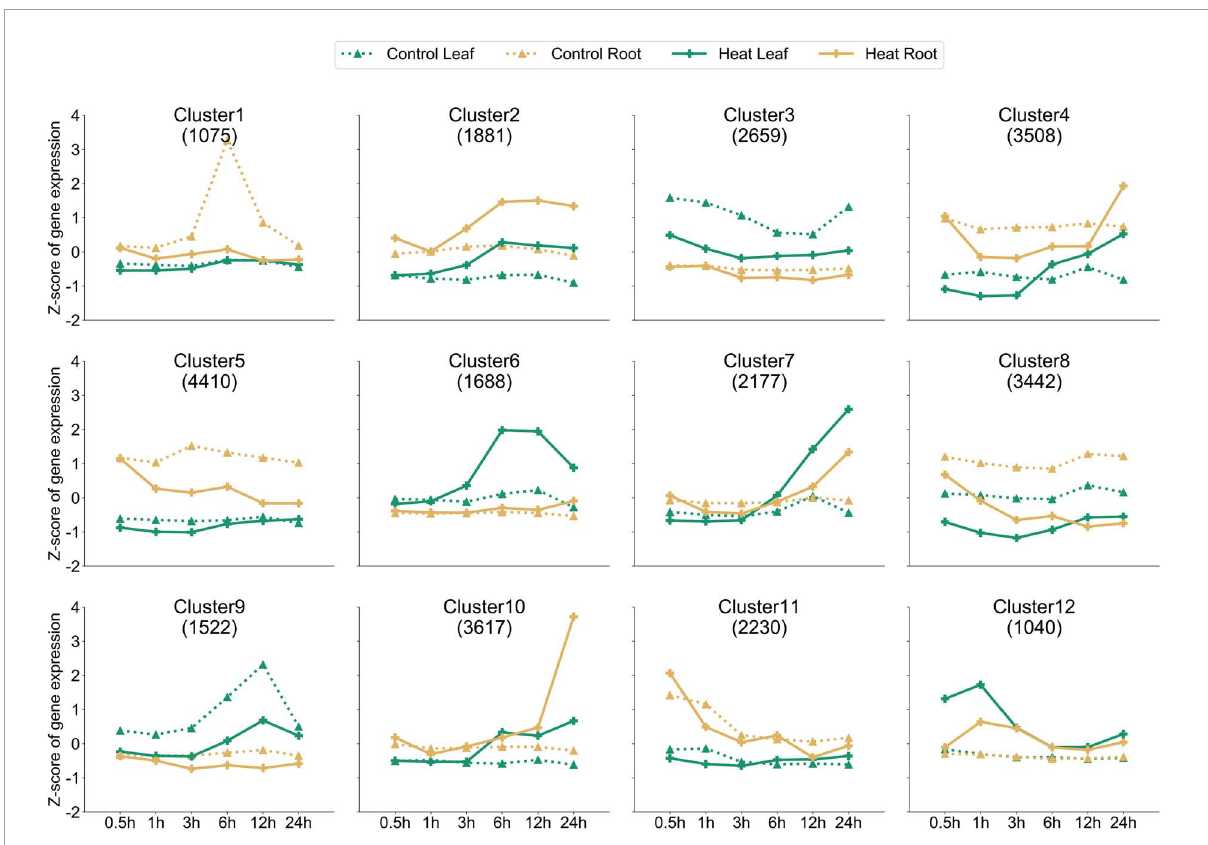
FIGURE3 Dynamic gene expression. Twelve clusters (by k-means clustering) with different numbers of genes (shown under the cluster identification) are shown. The x -axis depicts six time points, and the y -axis depicts the standardized Z-score per gene. Dotted and solids lines (green for the leaf and orange for the root) denote the control and treated samples,